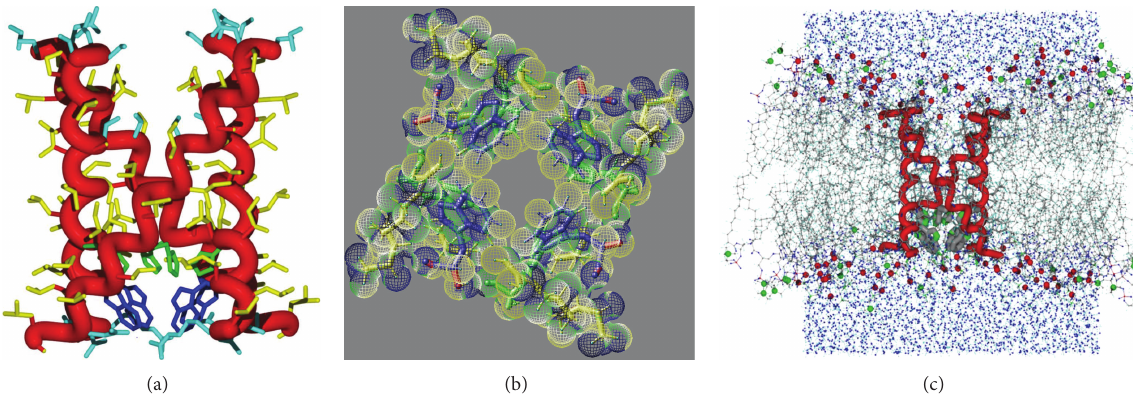
Figure 6: (a) The initial structure of M2 TMD from the Protein Data Base (1NYJ). Trp-41 are shown in blue, His-37 in green, hydro- philic/charged amino acid side chains in light blue, all other side chains in yellow. (b) View along the channel with a network colored by the electrostatic potential (from blue to red corresponding to negative to positive). (c) Equilibrated box with a size of 60 3 > 3 , containing 128 DMPC lipid, 3000 water molecules, and the M2 TMD structure in the centre.